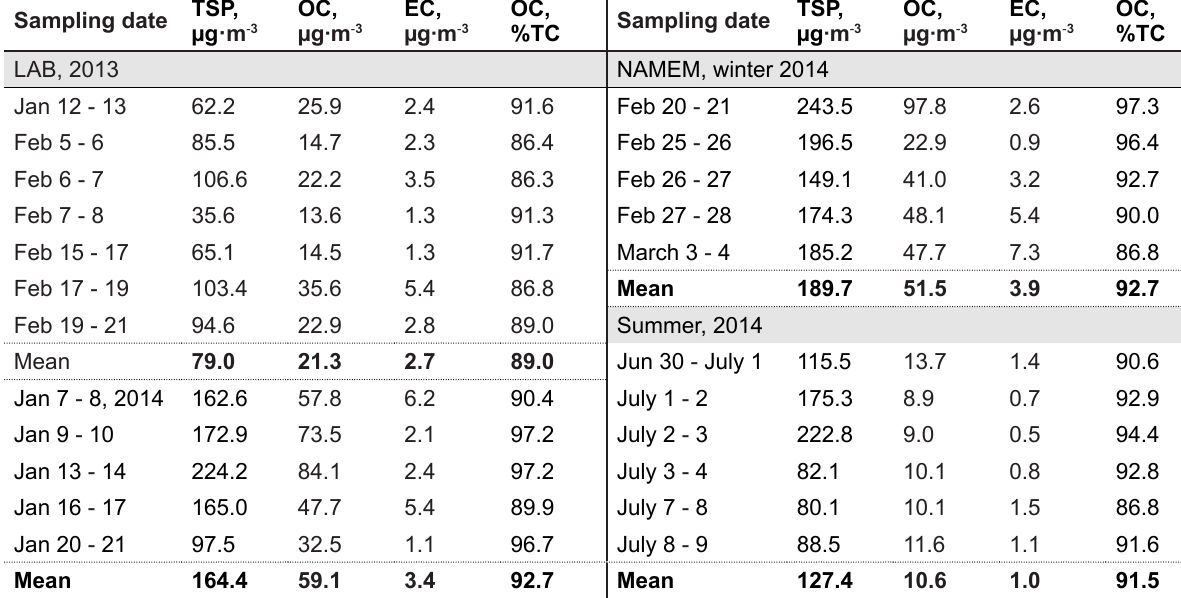
Table 1. Elemental and organic carbon contents of TSP in Ulaanbaatar atmospheric aerosol, 2013 and 2014 (LAB and NAMEM